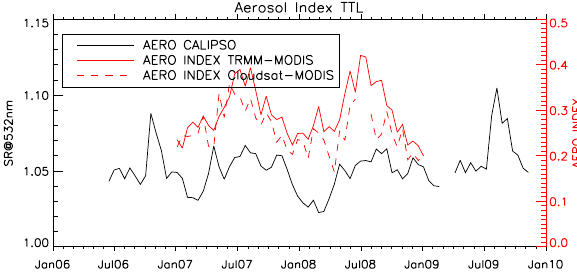
Fig. 7. CALIPSO mean SR between 14–17km (black line) within the “ITCZ area” delimited by the 10th and 90th percentile of the CALIPSO cloudy pixel product derived from the depolarization (Fig. 5). The Aerosol Indices are derived from TRMM (red solid line) and CloudSat (dotted red line) MCSs located between 20 ◦ N– 20 ◦